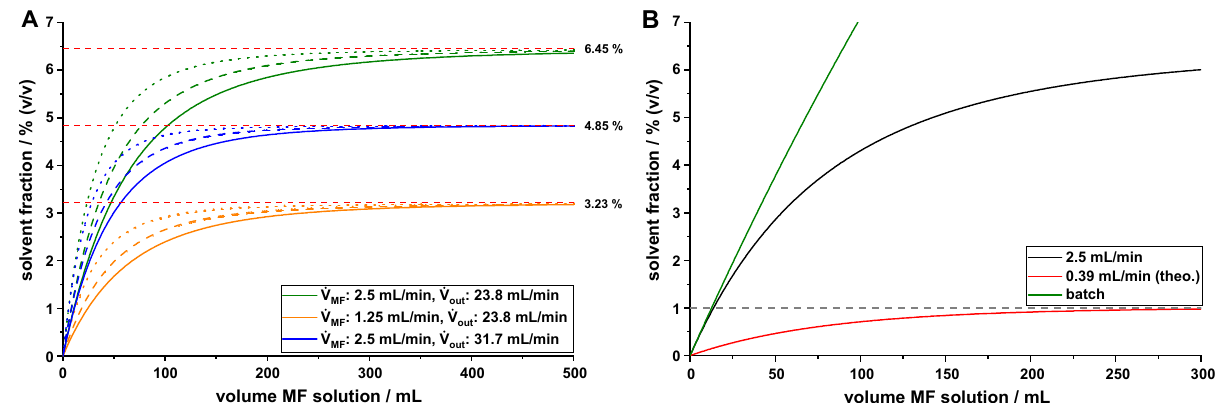
Figure 4. ( A ). Examples of calculated solvent fraction during QESD MF crystallization with different V 0 (straight lines: 600 mL, dashed lines: 450 mL, dotted lines: 300 mL); ( B ). comparison of solvent fraction between batch and MSMPR setup at V 0 = 600 g acetone and 𝑉(cid:4662) (cid:2925)(cid:2931)(cid:2930) = 23.8 mL/min for the MSMPR trials.